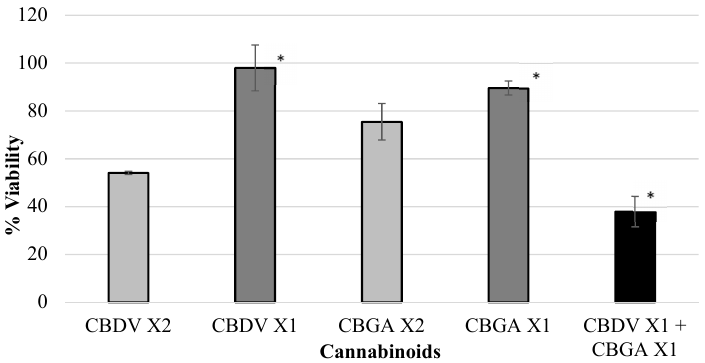
Figure 4. Viability of polyp cells exposed to CBDV and CBGA. Combinations between CBDV (at X2 concentration—47 µM or X1 concentration—23.5 µM) and CBGA (at X2 concentration—51.2 µM or X1 concentration—25.6 µM) significantly inhibited the viability of polyp-derived cells. The cannabinoid combination CBDV + CBGA presented a synergistic effect (* p < 0.0004, Bliss equation calculation = 0.5). Legend: cannabidivarin (CBDV), cannabigerolic acid (CBGA).